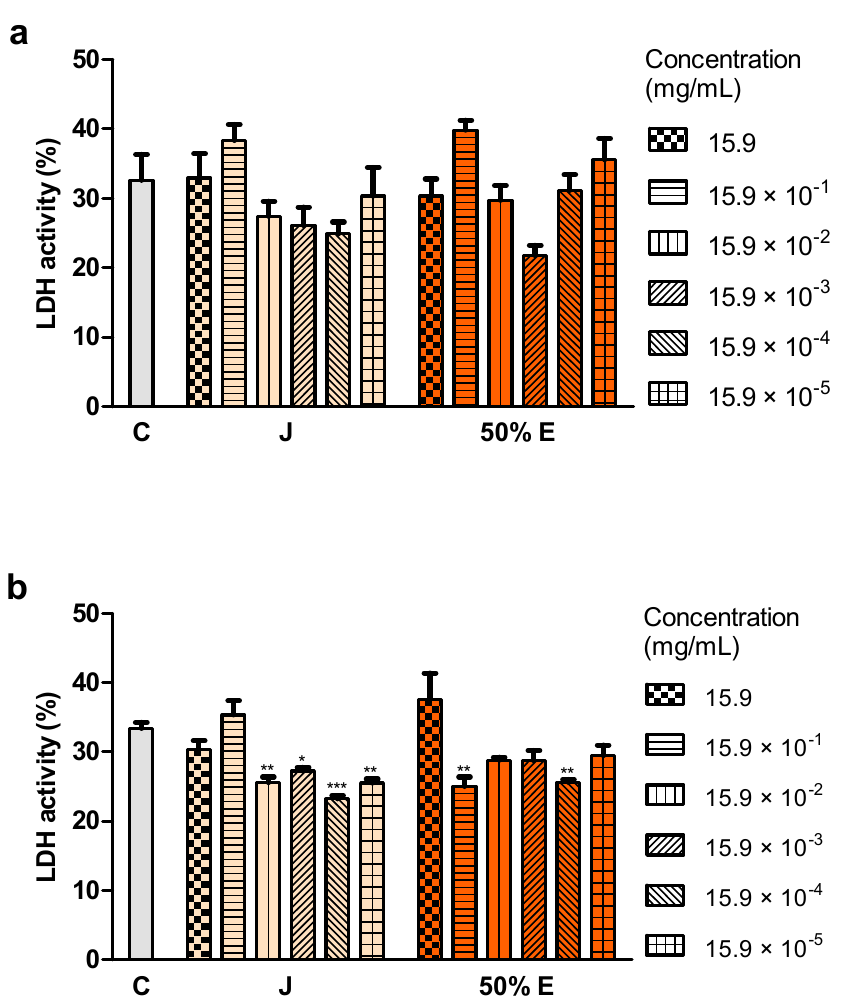
Figure 5. Integrity of membranes of Caco-2 cells after ( a ) 24 h and ( b ) 72 h of treatment with juice (J) and 50% hydroethanolic extract (50% E) from Saposhnikovia divaricata root, at different concentrations. C—control cells (treated with deionized water), LDH—lactate dehydrogenase. Error bars indicate standard error of the mean. Statistically significant effect: * represents values that differ from control at p < 0.05, ** represents values that differ from control at p < 0.01, *** represents values that differ from control at p < 0.001. n = 6.